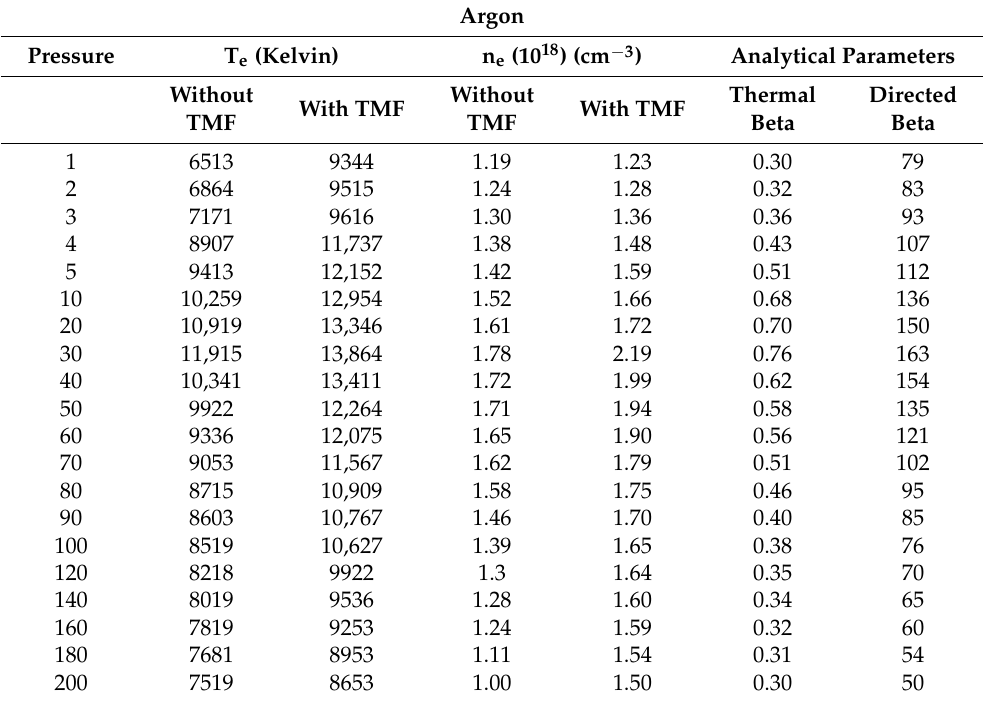
Table 2. Evaluated T e , n e , β t , and β d values for laser-irradiated Cu-alloy plasma at various Ar pressures in the presence and absence of TMF.